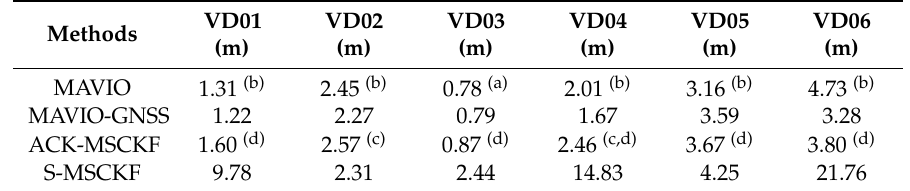
Table 5. The average absolute trajectory error (ATE) along the whole trajectory for each experimental dataset.